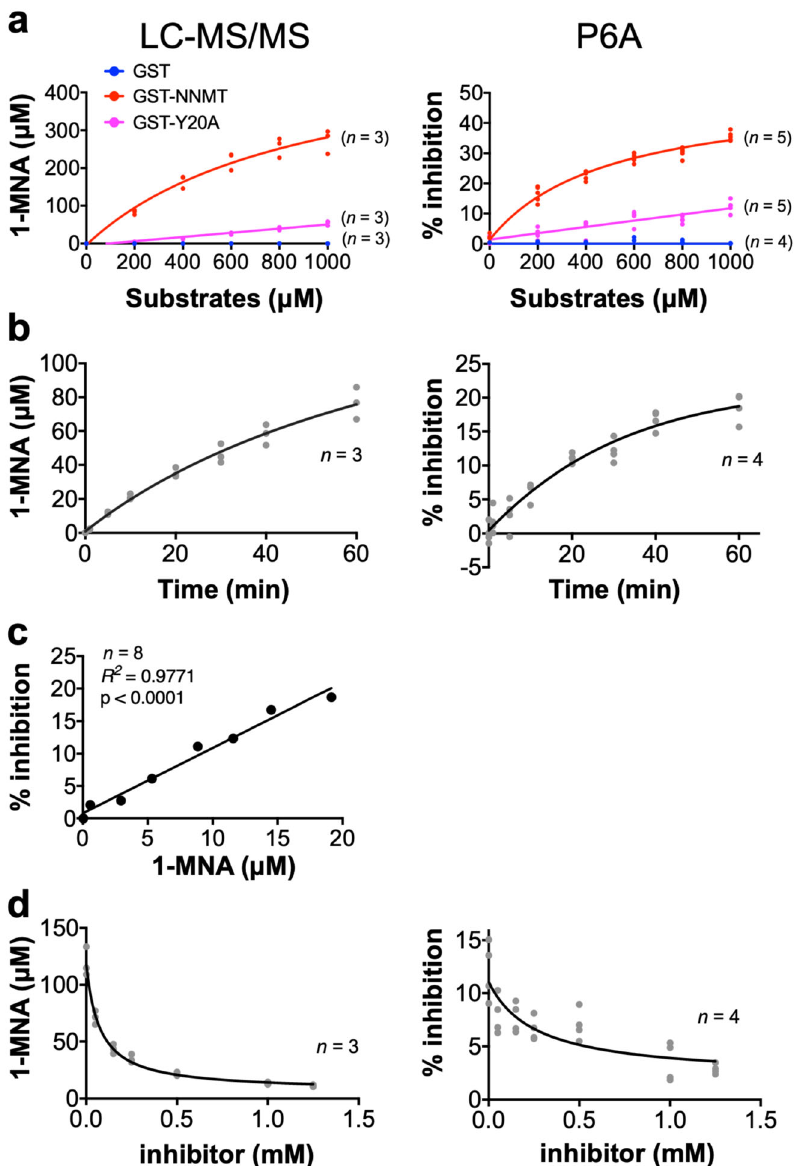
Fig. 5 P6A speci fi cally and quantitatively monitors the enzymatic activity of NNMT in a cell-free reaction system. a , b 1-MNA is produced by recombinant NNMT from nicotinamide in a ( a ) substrate-dependent and ( b ) time-dependent manner. c The linear correlation between the concentration of 1-MNA obtained from LC-MS/MS and the % inhibition obtained from the fl uorescent measurements. Line represents the linear regression calculation ( n = 8). d Inhibition of 1-MNA production by a NNMT inhibitor. a , b , d The left panels show the quanti fi cation data using LC-MS/MS. The right panels are the data from fl uorescence spectra with